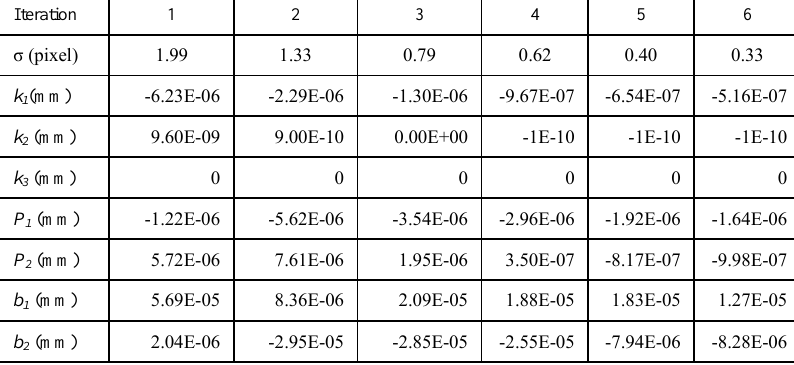
Table 3. The planimetric distortion coefficients (Australis Model) of Trial A